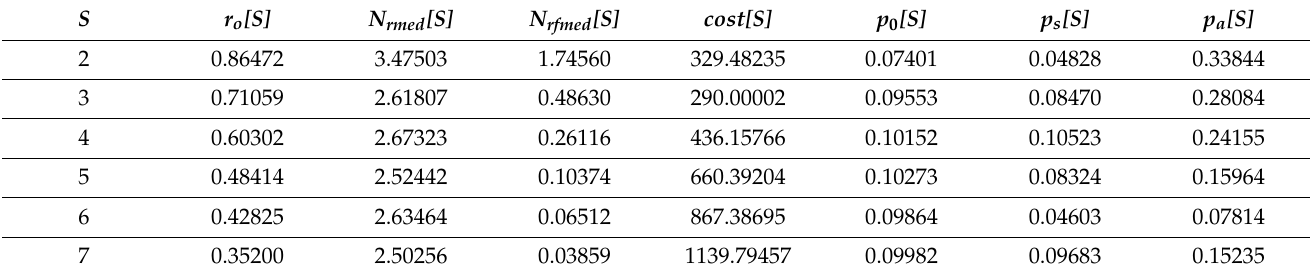
Table A7. Results for n = 5.